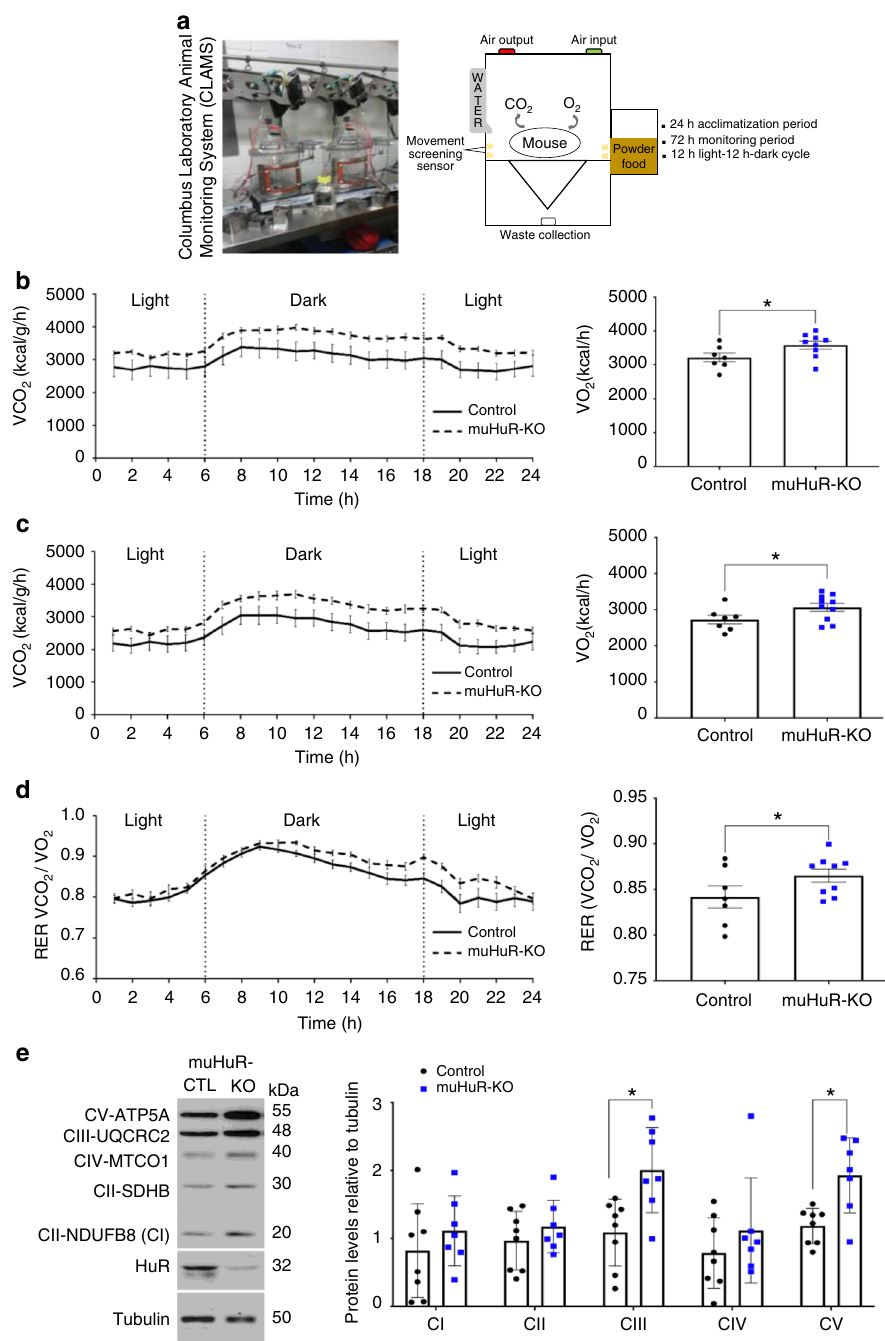
Fig. 3 muHuR-KO mice show an increased oxidative capacity . a Schematic illustrating the Comprehensive Animal Monitoring System (CLAMS; Columbus Instruments, Columbus, OH) that was used to complete a 3-day indirect calorimetry study in age-matched mice under a 12 h light – 12 h dark cycle. b , c Oxygen consumption (V ̇ O 2 ) ( b ), and carbon dioxide production (V ̇ CO 2 ) ( c ) were measured over the 3 days following a 24-h acclimation period. d Respiratory exchange ratio (RER) was calculated as the ration of V ̇ CO 2 /V ̇ O 2 . The graphs on the left depicts the average values at each time point while that on the right shows the average or cumulative (only for activity) values over the 72 h period. b – d Data obtained was analyzed using the CLAMS examination tool (CLAX; Columbus Instruments) version 2.1.0. (Control: n = 7, muHuR-KO: n = 9). The results are presented as mean ± S.E.M, * p < 0.05 unpaired t -test. e Left panel: western blot analysis of levels of OXPHOS complexes in the mitochondria of control and muHuR-KO mice. Right panel: quanti fi cations of the levels of the complexes are presented as the mean ± S.E.M, * p < 0.05 unpaired t -test (control: n = 8, muHuR-KO: n = 7). Source Data are provided in the Source Data